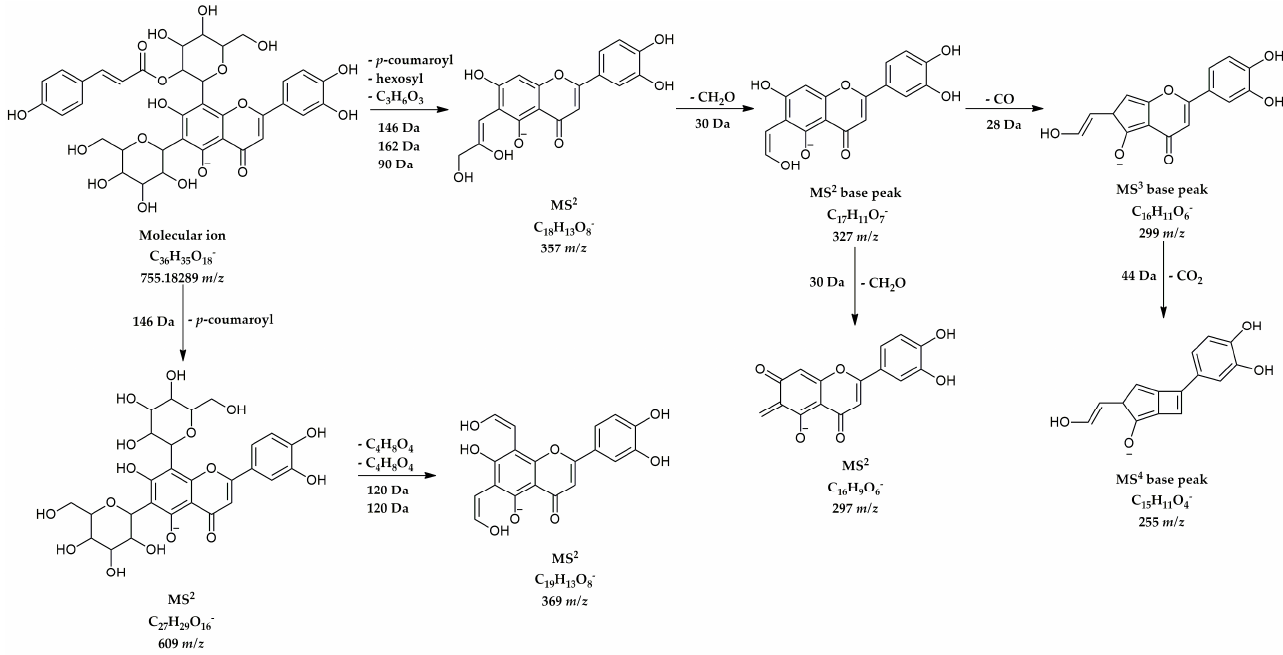
Figure 3. The chemical structure and proposed MS fragmentation pathway of compound 27 .